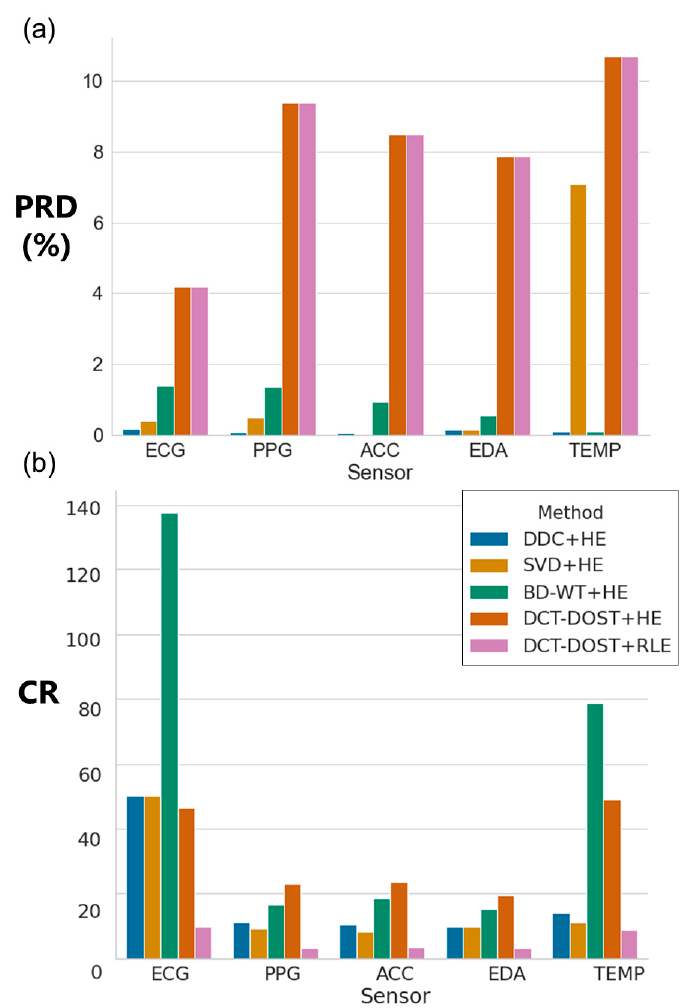
Figure 2. Comparison of ( a ) PRD and ( b ) CR for each method across the wearable sensors ECG, PPG, accelerometry (ACC), electrodermal activity (EDA), and skin temperature (TEMP).